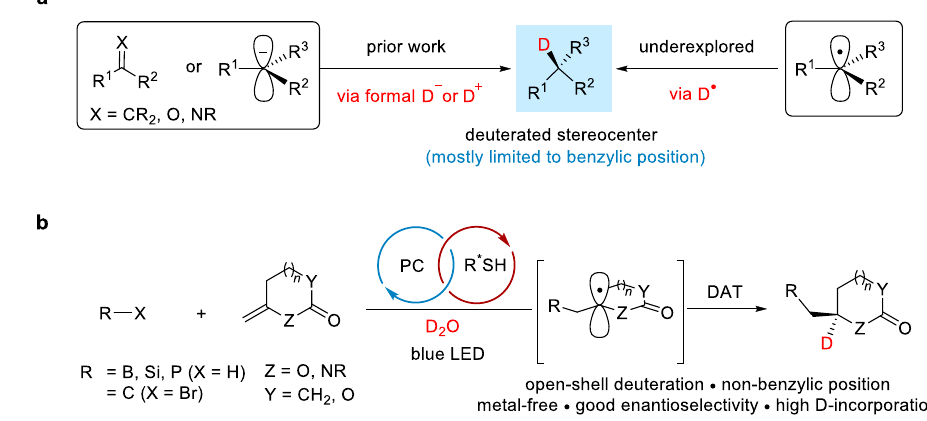
Fig. 1 | Strategies for the construction of deuterated stereocenters. a Catalytic asymmetric deuterationviaa closed-shell mechanism involving formal deuteride (D – ) or deuteron (D + ) or via an open-shell deuterium atom transfer